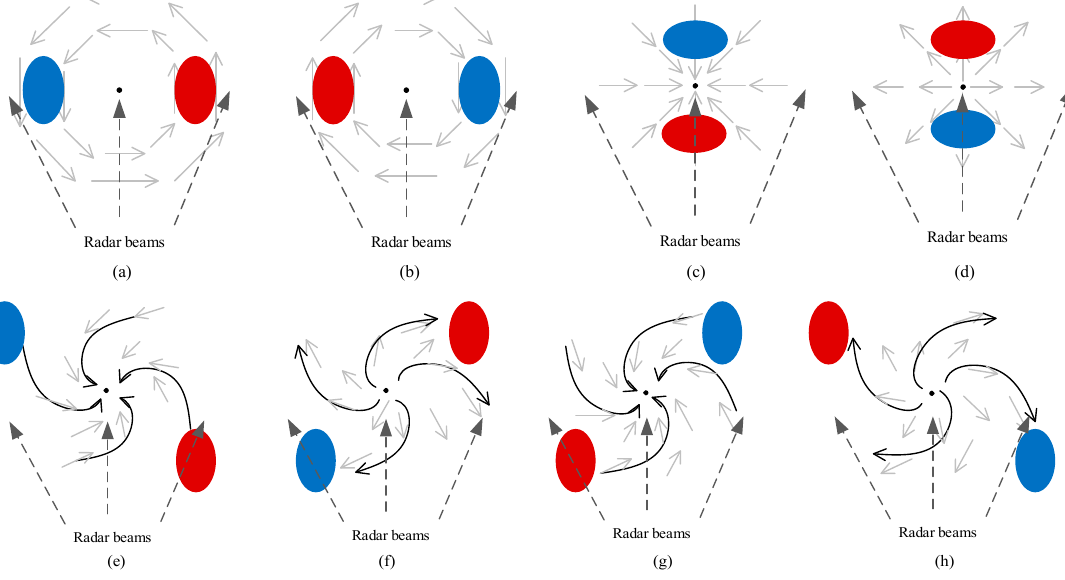
Figure 1. Velocity structures of the Meso- γ scale system: ( a ) Pure cyclonic rotation flow field. ( b ) pure anticyclonic rotation flow field, ( c ) pure convergence flow field, ( d ) pure divergence flow field, ( e ) cyclonic convergence flow field. ( f ) cyclonic divergence flow field, ( g ) anticyclonic convergence flow field, and ( h ) anticyclonic divergence flow field. The central point of each subgraph represents the center of the airflow field and the radar is located directly below the center of the airflow field. Blue ellipses represent the maximum inflow velocity centers, and red ellipses represent the maximum outflow velocity centers. Grey and black solid arrows represent the wind directions and black dashed arrows represent the radar beams.